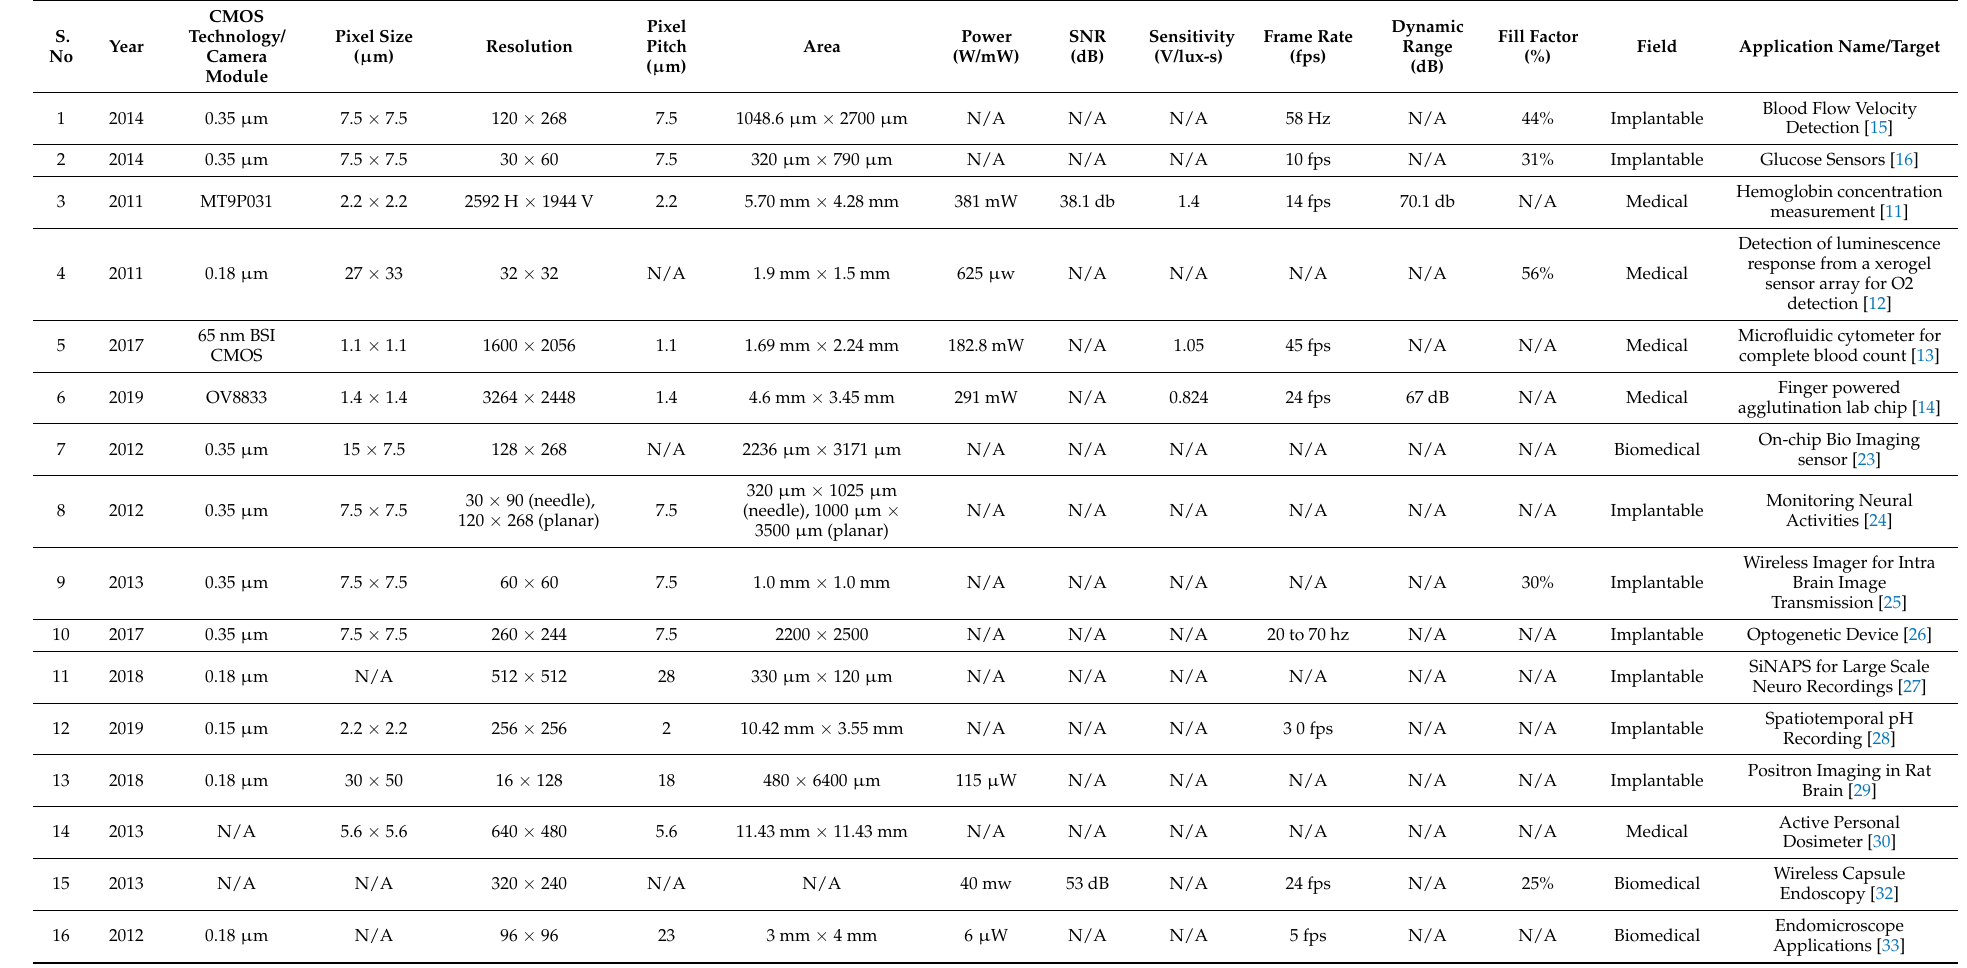
Table A1. Parametric data of complementary metal-oxide semiconductor (CMOS) image sensors used in medical devices performing disease